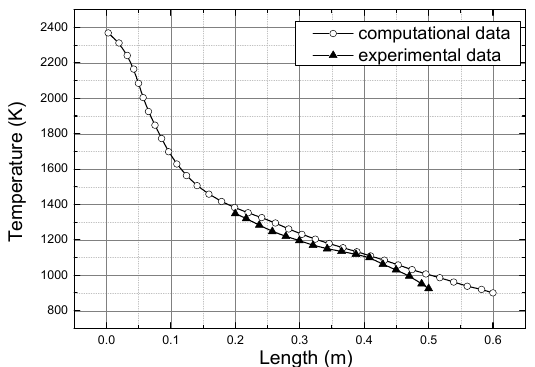
Figure 8. Comparison chart of monitor values and computational values.